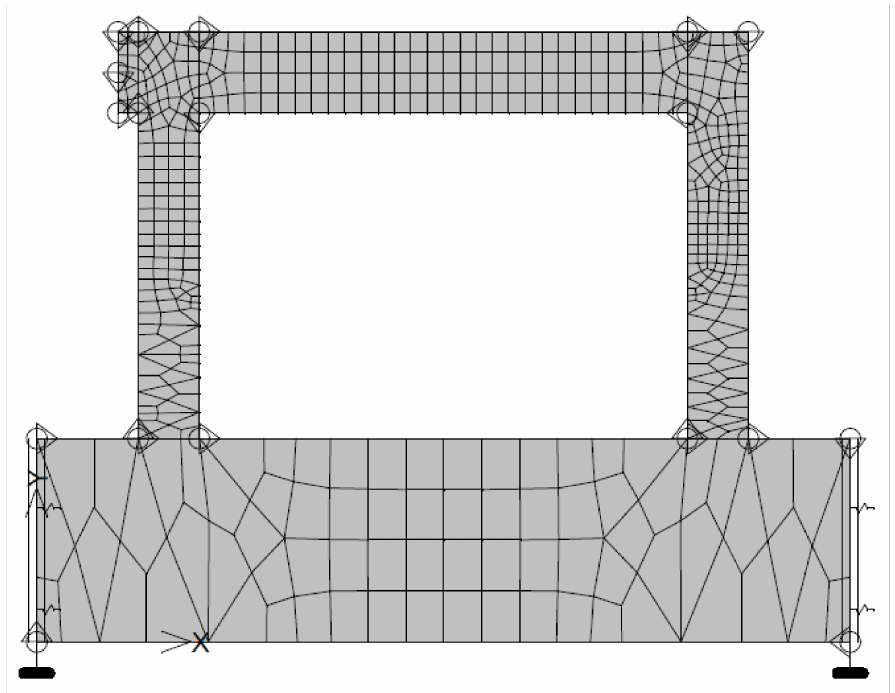
Figure 3. FE model of the investigated frame